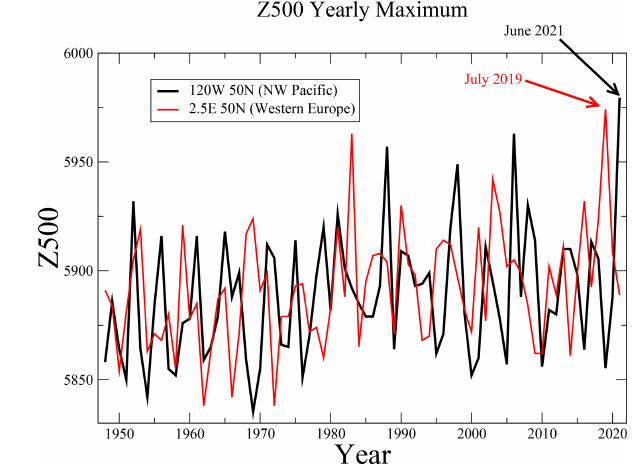
Figure 14. Annual maximum 500hPa height (m) for two points at the same latitude on two continents. Black: Pacific Northwest (as above); red: western Europe (50 ◦ N, 2.5 ◦ E). Data source: NCEP initialised reanalysis (Kalnay et al.,